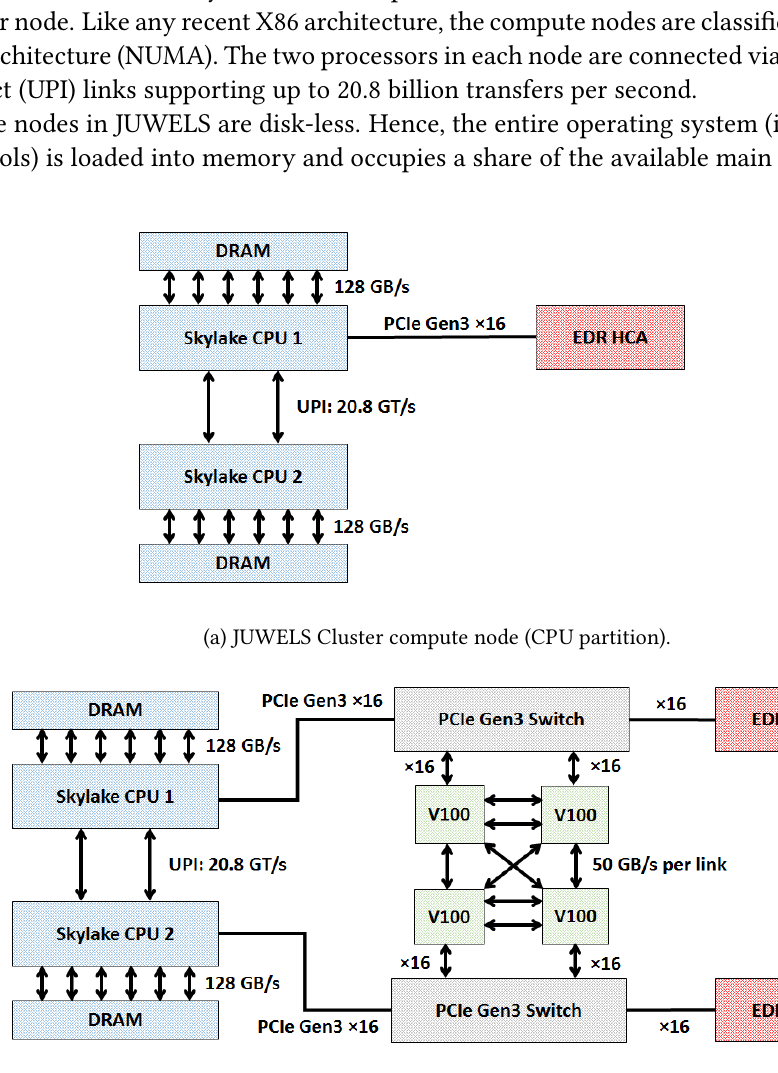
Figure 3: Annotated block diagrams of JUWELS Cluster compute